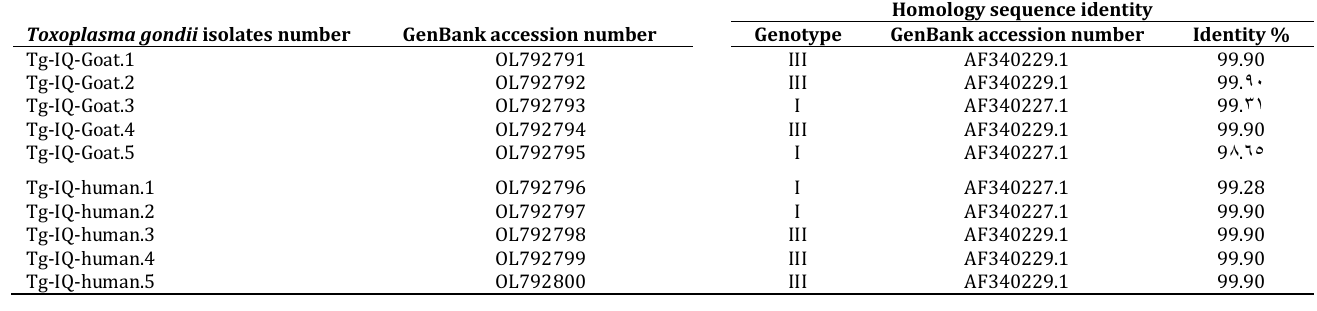
Table 5. Homology sequence identity between Toxoplasma gondii isolated from local goats and humans isolates compared to Toxoplasma gondii genotypes deposited on NCBI BLAST